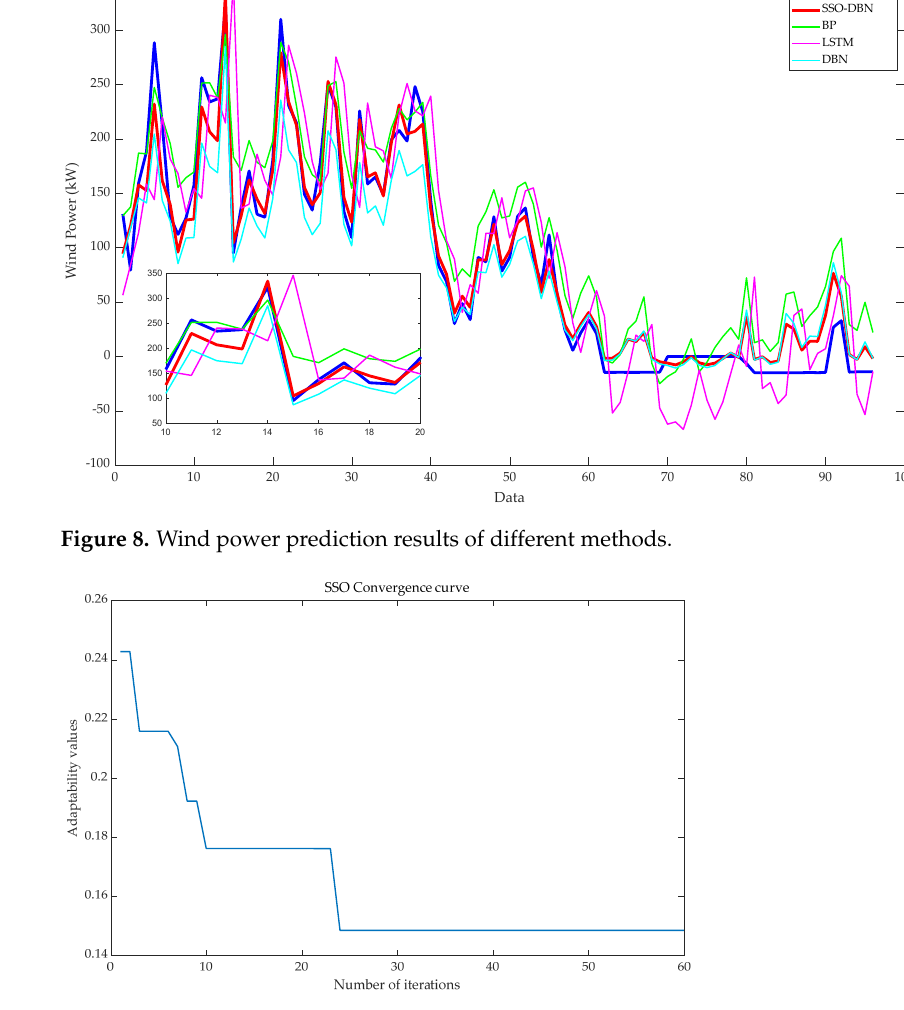
Figure 9. Convergence curve of SSO (Wind Power). Table 3. Prediction results evaluation form (Wind Power).